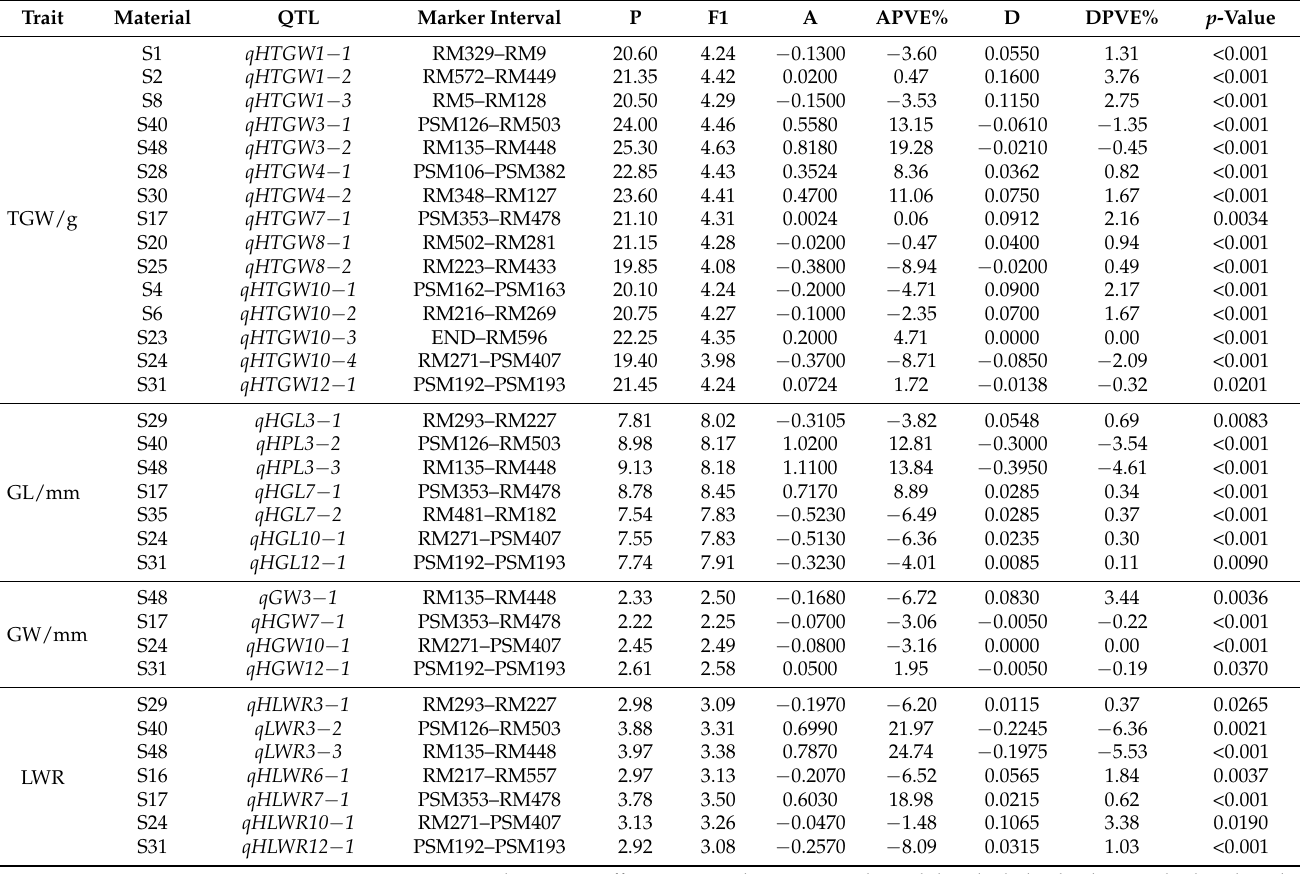
Table 2. Effects of heterosis loci on MPH/dominance for grain shape (n =